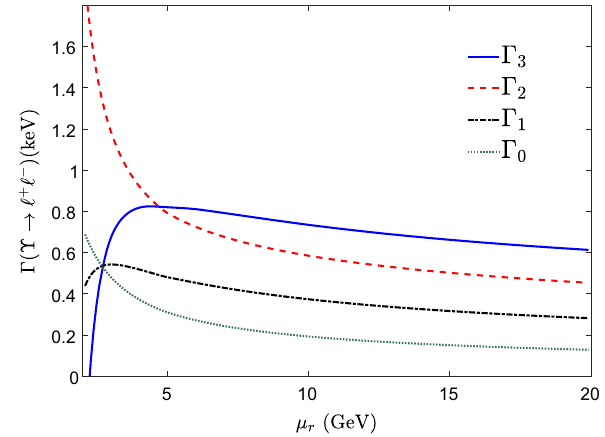
shall be shown below, the residual scale dependence for a N 3 LO decay width (cid:3) ϒ( 1 S ) → e + e − is negligible due to both α s -suppression and exponential